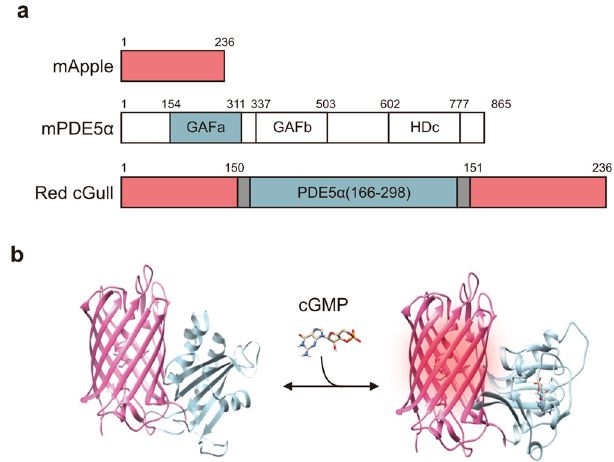
Fig. 1 Schematic representations of mApple, mPDE5 α , and Red cGull. a Diagrams of mApple, mPDE5 α and Red cGull. mPDE5 α contains GAF domains for cGMP binding and HD domains for phosphodiesterase activity. See also Fig. S1. b Three-dimensional schematic images of Red cGull unbound (left) and bound (right) to cGMP. Images were created using structural data for mCherry (PDB_4ZIO) and PDE5 α (cGMP-unbound: PDB_3MF0; cGMP-bound: